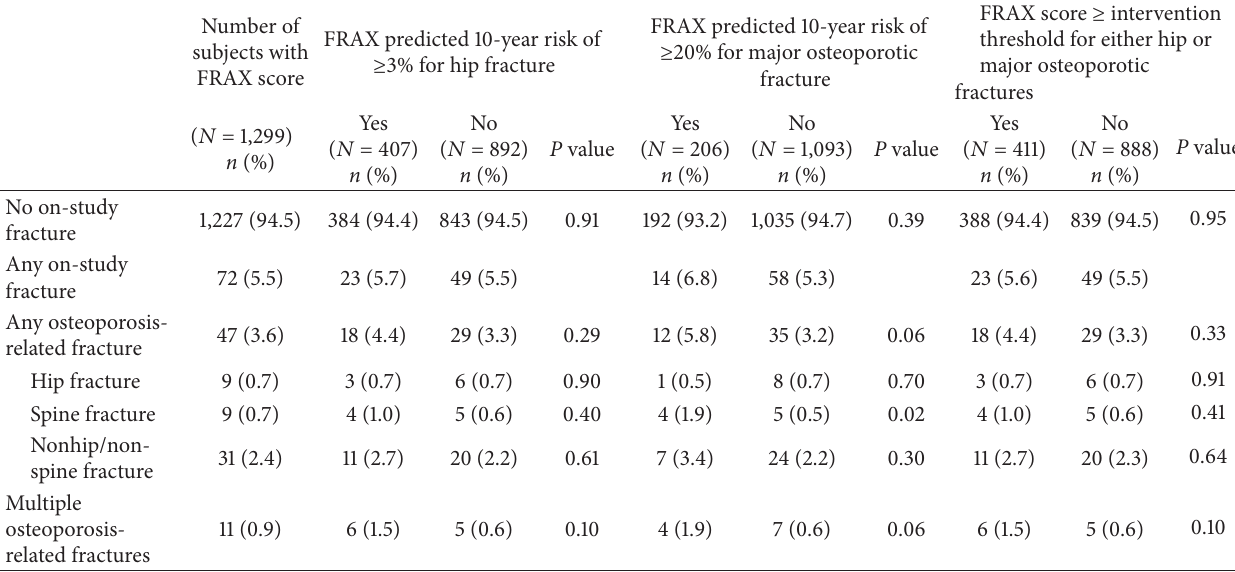
Table3:Self-reportedon-studyfractureamongnonpharmacologicallytreated a POSSIBLEUSsubjectsstratifiedbytheNationalOsteoporosis Foundation treatment thresholds.